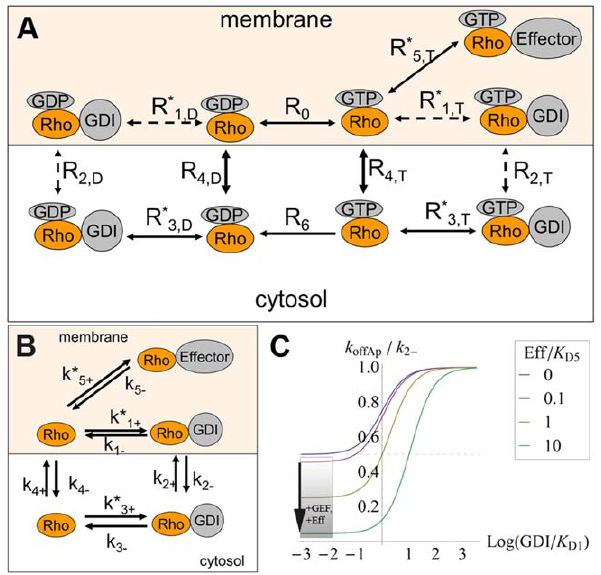
Figure 1. Models for GTPase membrane cycling. The asterisk represents the product between binding rates and concentration of GDI (subscripts that carry the numbers 1 and 3) or effector proteins Eff (subscript 5). In all models presented, the numbers used as subscripts for the cycling rates are consistent: 1 stands for interactions between membrane bound GTPase and GDI; 2 for membrane cycling of the complex GTPase-GDI; 3 for interactions between cytosolic GTPase and GDI; and 4 for membrane cycling of GTPase free from GDI. A. Detailed model. B. GDI dependent and independent GTPase cycling. Rates with subscript ‘‘ + ’’ represent binding (to GDI, effector proteins or mem- brane). C. Apparent membrane dissociation rate ( k offAp ) normalized by the GDI mediated dissociation rate k 2 2 as a function of K D1 , K D5 , GDI and Eff .